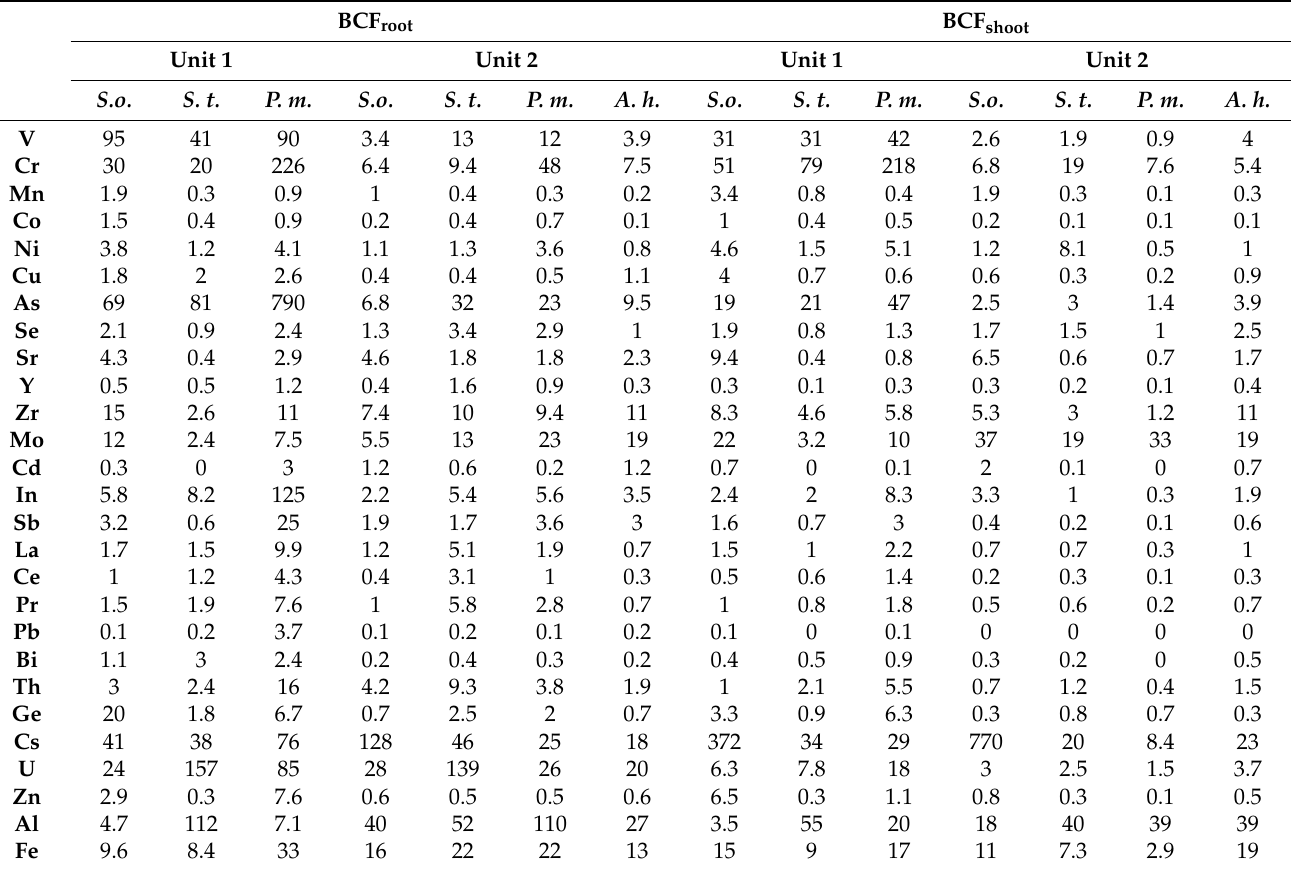
Table 6. Bioaccumulation Factor (BCF) for different metal(loid)s and REEs in Unit S1 and Unit